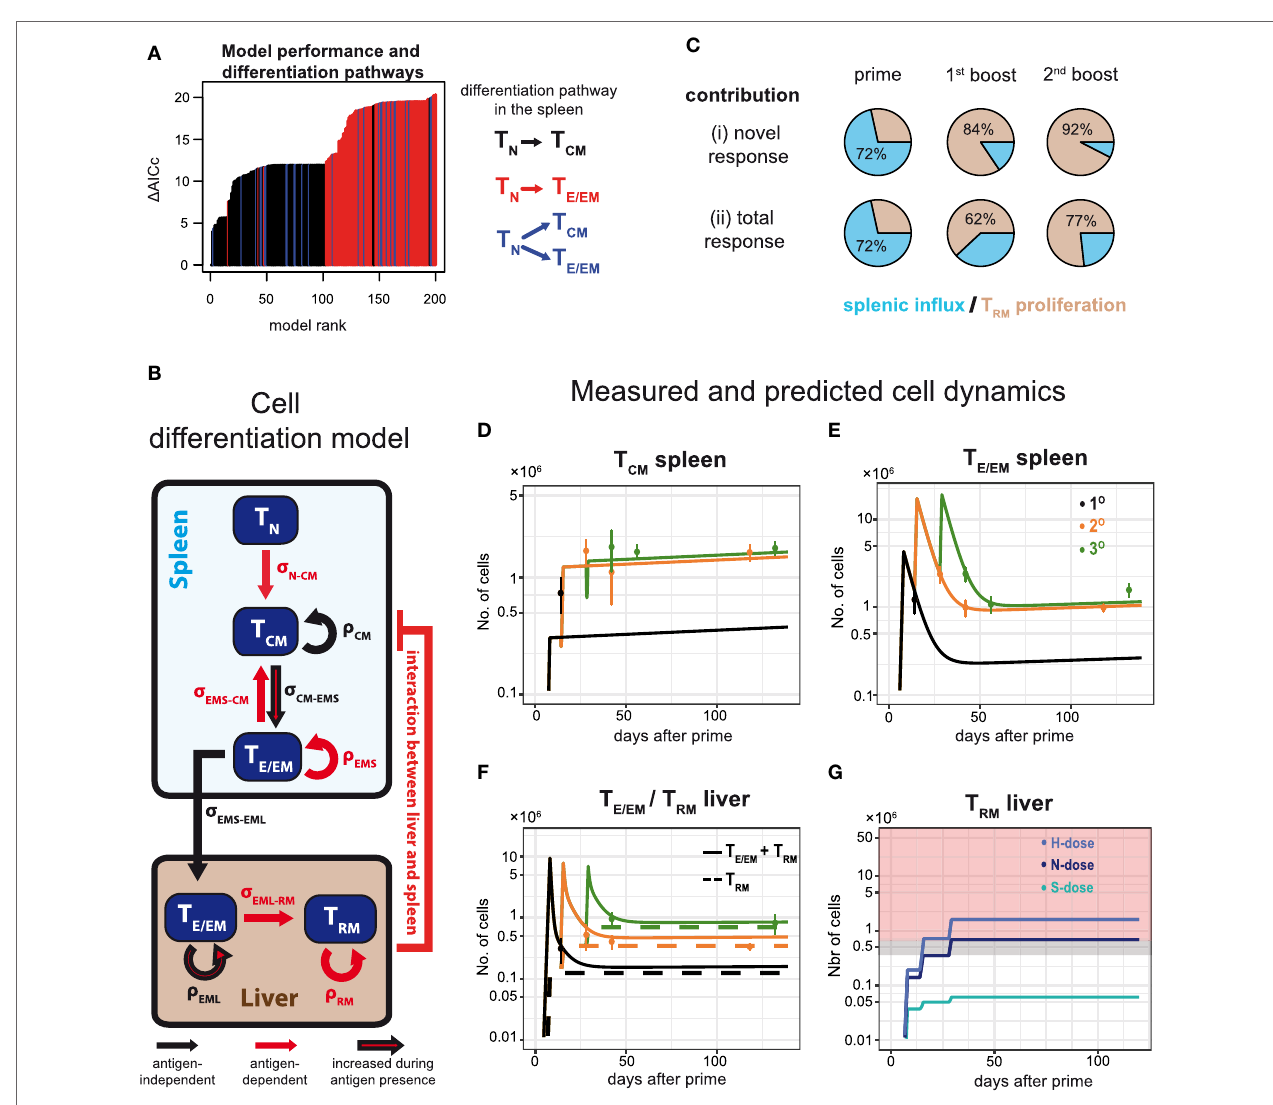
FigUre 6 | Examining CD8 + T cell differentiation dynamics in response to varying vaccination protocols using mathematical models. (a) The 200 best fitting models explaining CD8 + T cell activation and differentiation dynamics in N-dose vaccinated mice ranked according to the corrected Akaike Information criterion (AICc). Nearly all of the best performing models assume a linear T N –T CM cell differentiation pathway (black) in the spleen. For a detailed explanation of the mathematical models and the unbiased model selection algorithm see Appendices A1 and A2 in Supplementary Material. (B) Schematic of the mathematical model best explaining the observed dynamics indicating proliferation, ρ , and cell migration/differentiation, σ , rates. Processes only active during the immunization periods are indicated in red. (c) Proportion of T RM cells in the liver originating from local reactivation (ocher) or additional influx from the spleen (blue) after each prime and boost distinguished between the newly generated (i) and the total response (ii). (D–F) CD8 + T cell dynamics predicted by the model shown in (B) for the numbers of T CM and T E/EM cells in the spleen (D,e) , as well as the numbers for T RM and the total T E/EM cells (T RM + T EML ) in the liver (F) of N-dose vaccinated animals. Colored lines indicate the different vaccination protocols corresponding to prime (1°, black), prime-boost (2°, orange) or prime-boost-boost (3°, green). The corresponding measurements for the individual groups are shown as well (mean ± SEM). (g) Predicted dynamics of liver-resident T RM cells for different doses according to the basic vaccination protocol. Gray and red shaded areas correspond to the number of T RM cells required to mediate 50 and 100% protection, respectively, as determined by the challenge